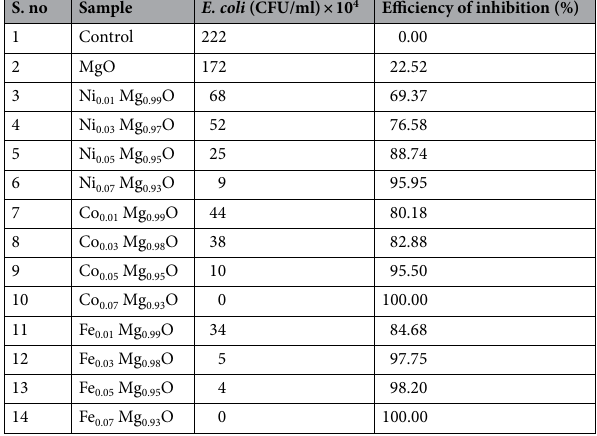
Table 8. The efficiency of inhibition of Ni, Co, and Fe-doped MgO nanoparticles at 80 μg/ml against E. coli.